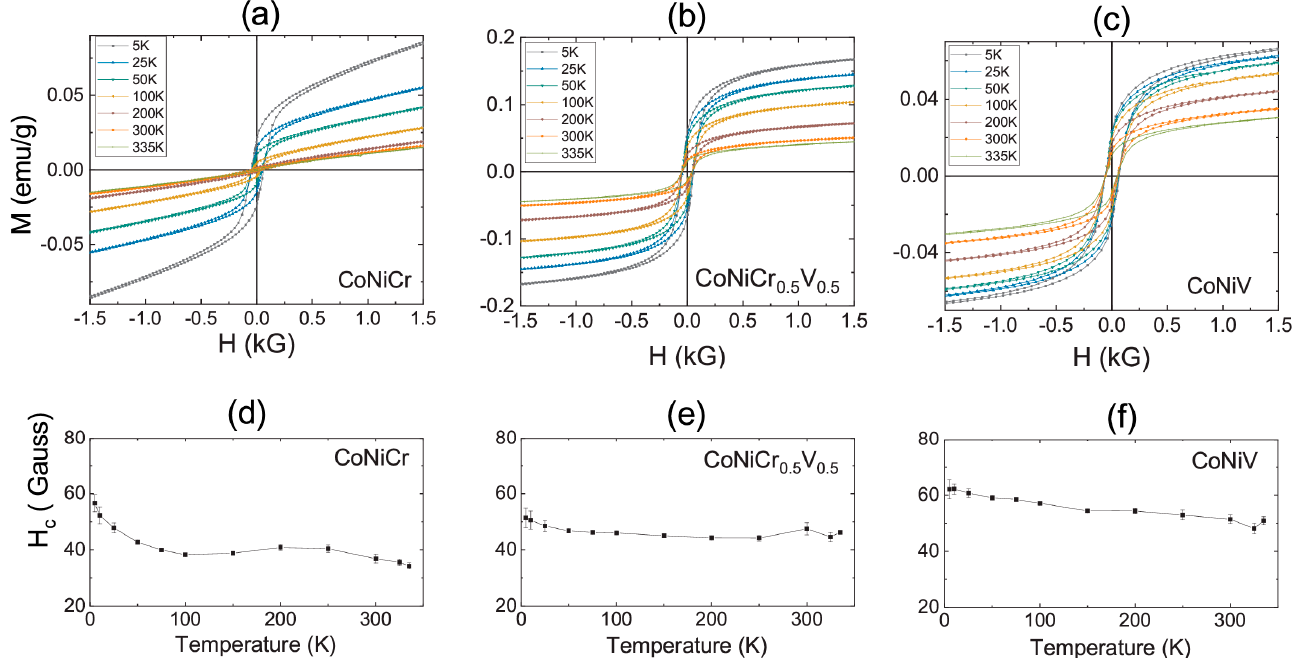
Figure 5. ( a – c ) The magnetizing field dependence of the magnetization of the CNC, CNCV, and CNV measured for various temperatures. ( d – f ) The temperature dependence of the coercive field of all samples.